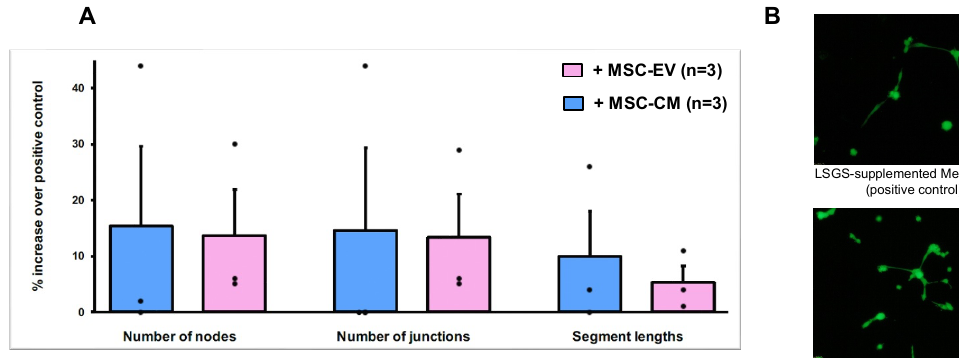
Figure 10. Tube formation of HUVECs incubated with MSC-CM or MSC-EV. (A ) Number of nodes, number of junctions, and number of segmentslength were quantified indifferent experimental conditions with the ImageJ software. The graphshowsthe percentage increase observed with the medium + MSC-CM or + MSC-EV compared to the positive control. Values represent means±SEMfromthreeindependentexperiments. (B ) Representative images (10× magnification, scale bar = 50 µm) of tube formation were taken using fluorescent microscopy (calcein-AMstaining),12haftercellseeding.